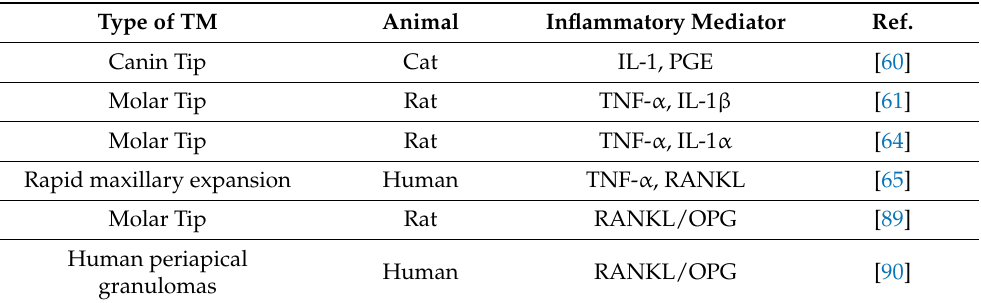
Table 2. Animal studies in inflammation and experimental tooth movement.